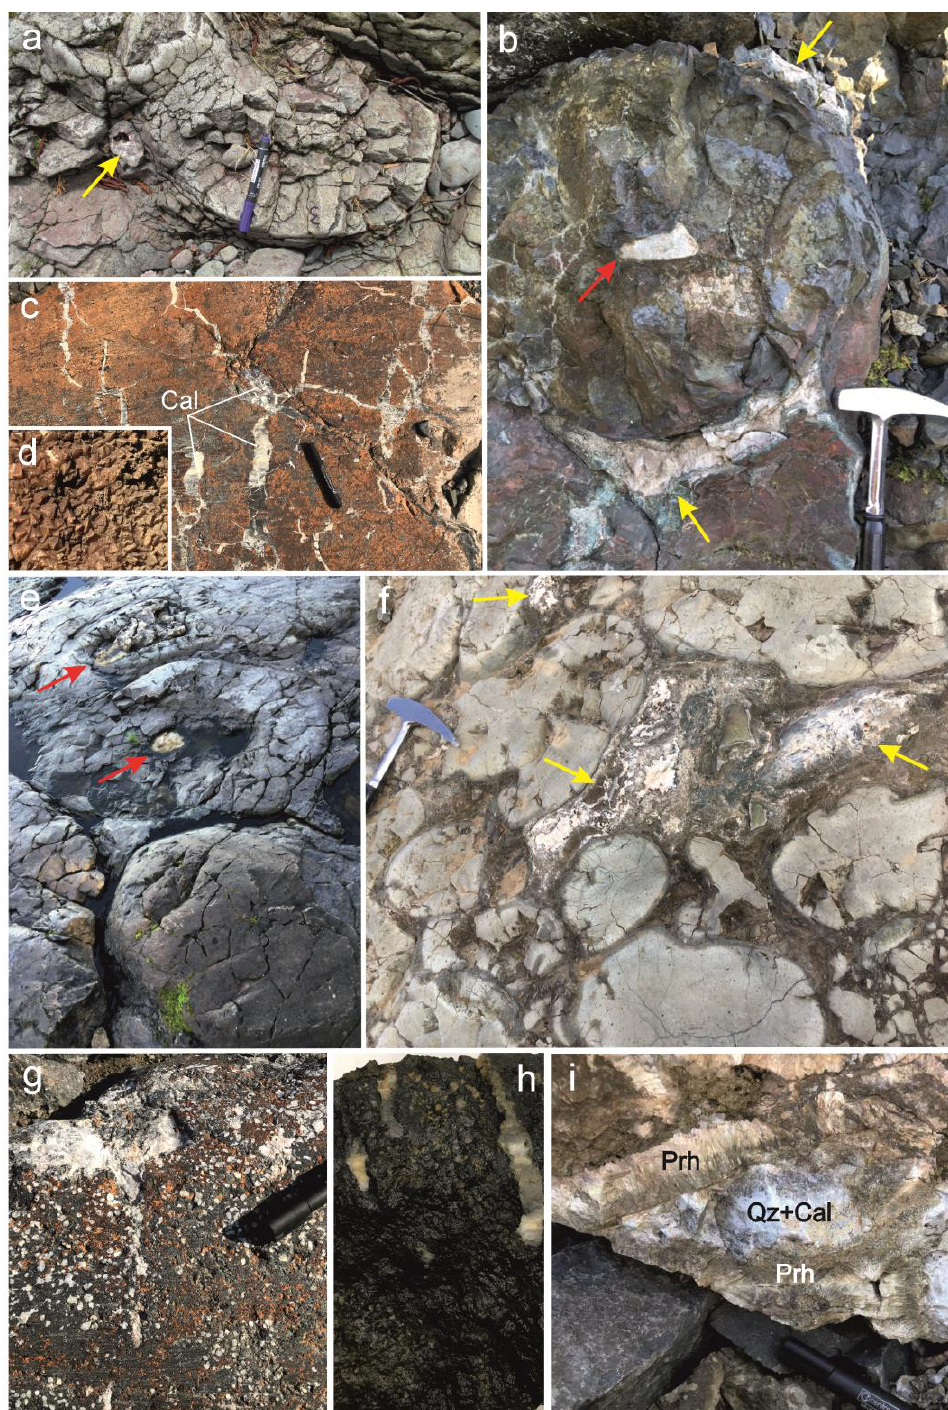
Figure 2. Field outcrop photographs illustrating the occurrences of main agate mineralization types in the Paleoproterozoic volcanics of the Onega Basin LSH. ( a ) Agate in the inter-pillow lava space (Pinguba); ( b ) agates in gas vesicle and inter-pillow pycrobasalt lava space (Yalguba Ridge); ( c ) carbonate veins in picrobasalt lavas (Yalguba Ridge); ( d ) scalenohedral calcite crystals from basalt fissure; ( e ) single agate amygdule in the pillow lava (Suisari Island); ( f ) agates in the inter-pillow lava space (Tulguba); ( g ) amygdales in the pycrobasalt top lava flow (Yalguba Ridge); ( h ) elongated pencil-like mineralized channels in pycrobasalt (cross-sectional view from ( g )); ( i ) quartz-prehnite-carbonate (Qz-Prh-Cal) vein in basalt fissure (Yalguba Ridge). Red arrows point to the agates in gas vesicles, yellow arrows –in inter-pillow lava space.